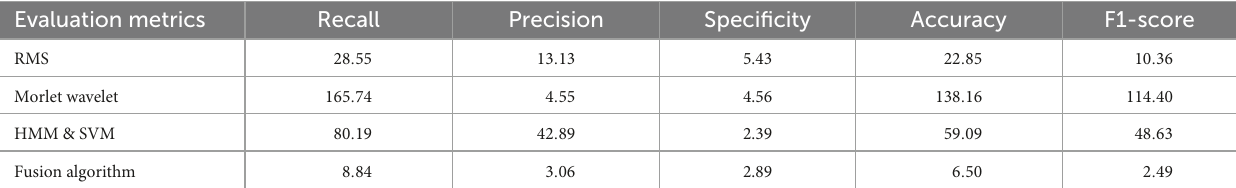
TABLE 3 Four automatic detection algorithms to evaluate metric